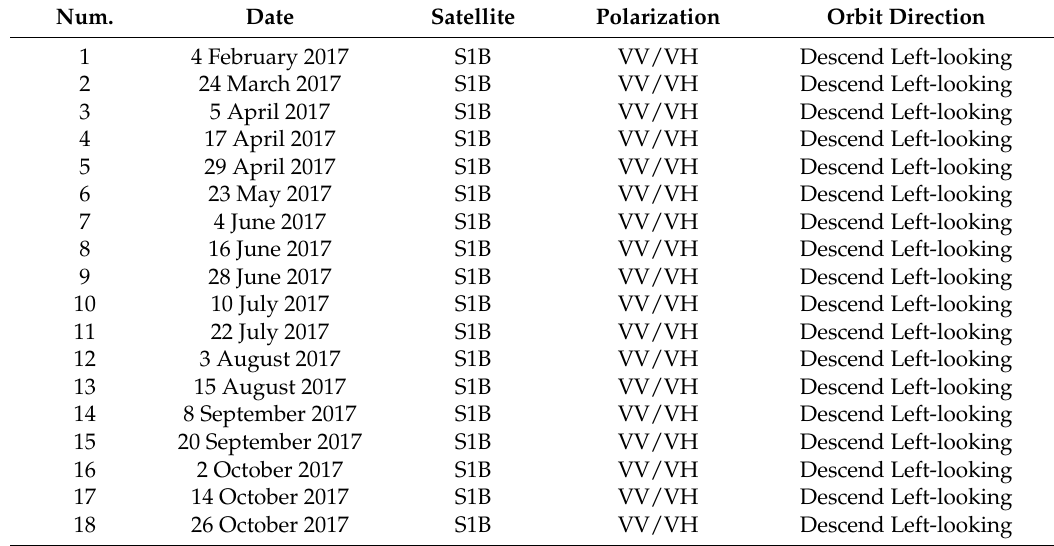
Table 1. Basic information of the experimental data.